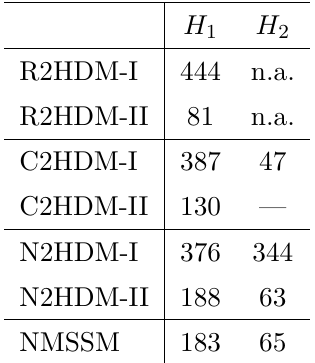
Table 7 . Maximum NLO QCD gluon fusion cross section values for resonant SM-like Higgs pair production in fb for the case where H models. In the R2HDM the case H H 2 H 2